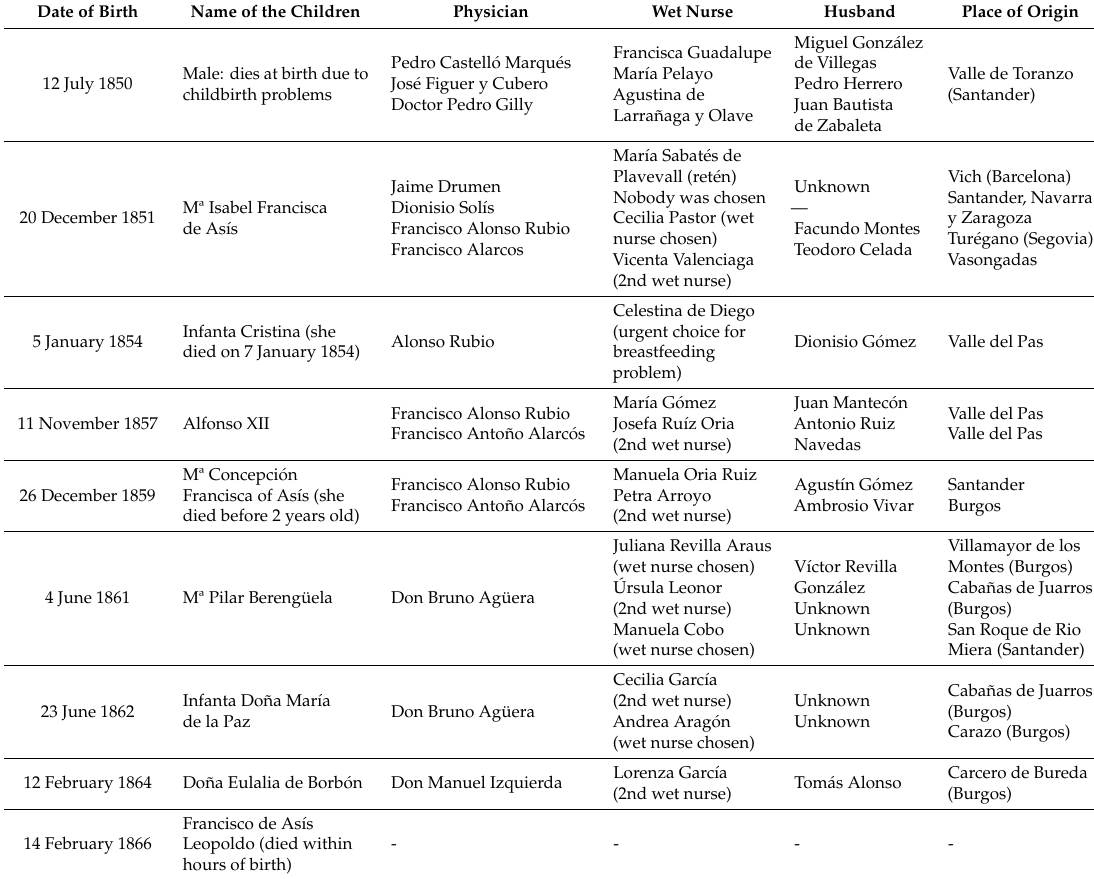
Table 4. Parenting of Elizabeth II’s children by wet nurses from northern